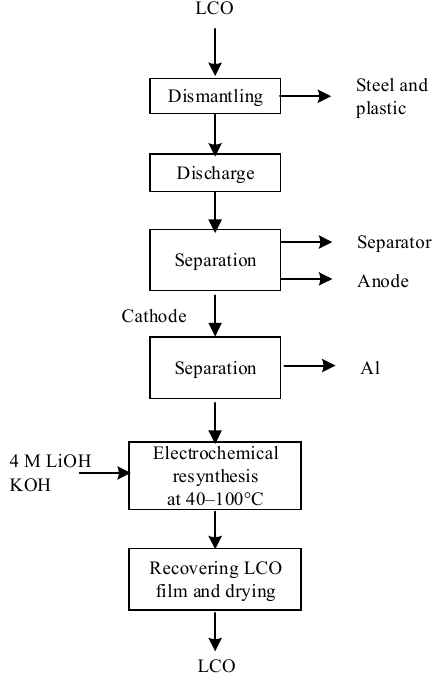
Figure 20. Electrochemical resynthesis process for LCO (according to [219]).